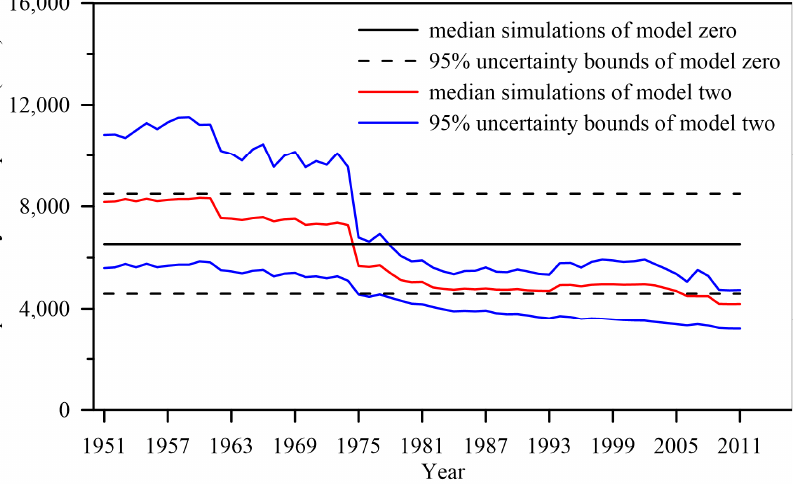
Figure 8. Variation of the estimated annual maximum floods for an exceedance probability of 0.01 based on model zero and two.